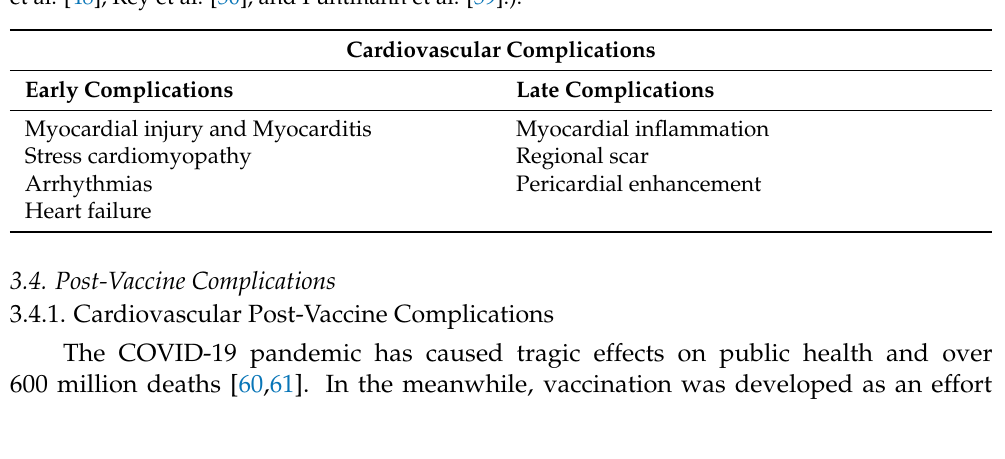
Table 2. Immediate and late cardiovascular complications reported in COVID-19 studies.